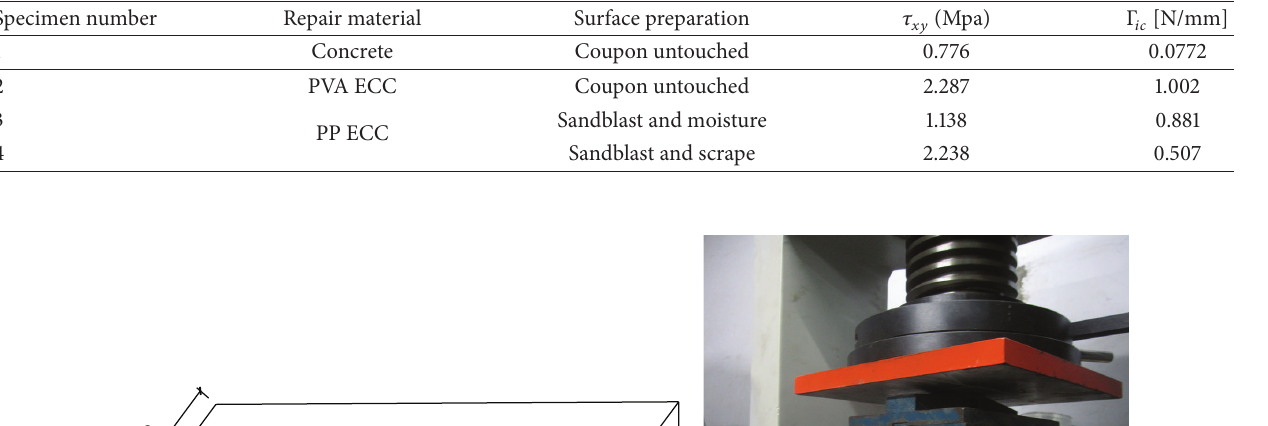
Table 2: The property of four interfaces with different preparation methods.